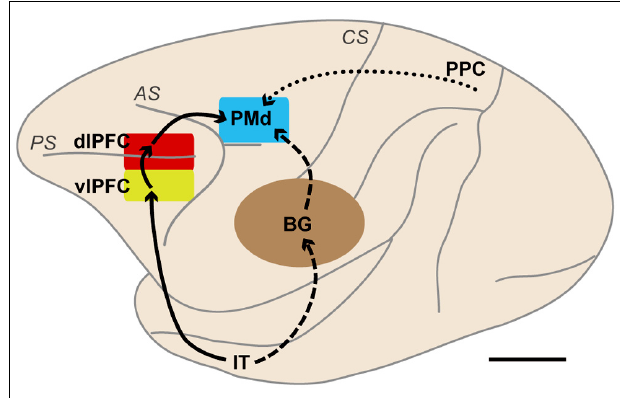
FIGURE 2 | Brain networks centered on the dorsal premotor cortex (PMd) involved in motor behavior based on visual object and visuospatial signals. The solid lines indicate a pathway from the IT to the PMd via the vlPFC and dlPFC.The broken lines indicate pathways from the IT to the PMd.These two types of pathways are thought to be involved in behavior based on visual-object signals, such as those involved in conditional visuomotor association and conditional visuo-goal association. The dotted line indicates a pathway from the PPC to the PMd.This pathway is considered to carry visuospatial information. BG, basal ganglia; dlPFC, dorsolateral prefrontal cortex; IT, inferotemporal cortex; PMd, dorsal premotor cortex; PPC, posterior parietal cortex; vlPFC, ventrolateral prefrontal cortex; AS , arcuate sulcus; CS , central sulcus; PS , principal sulcus. Scale bar, 10